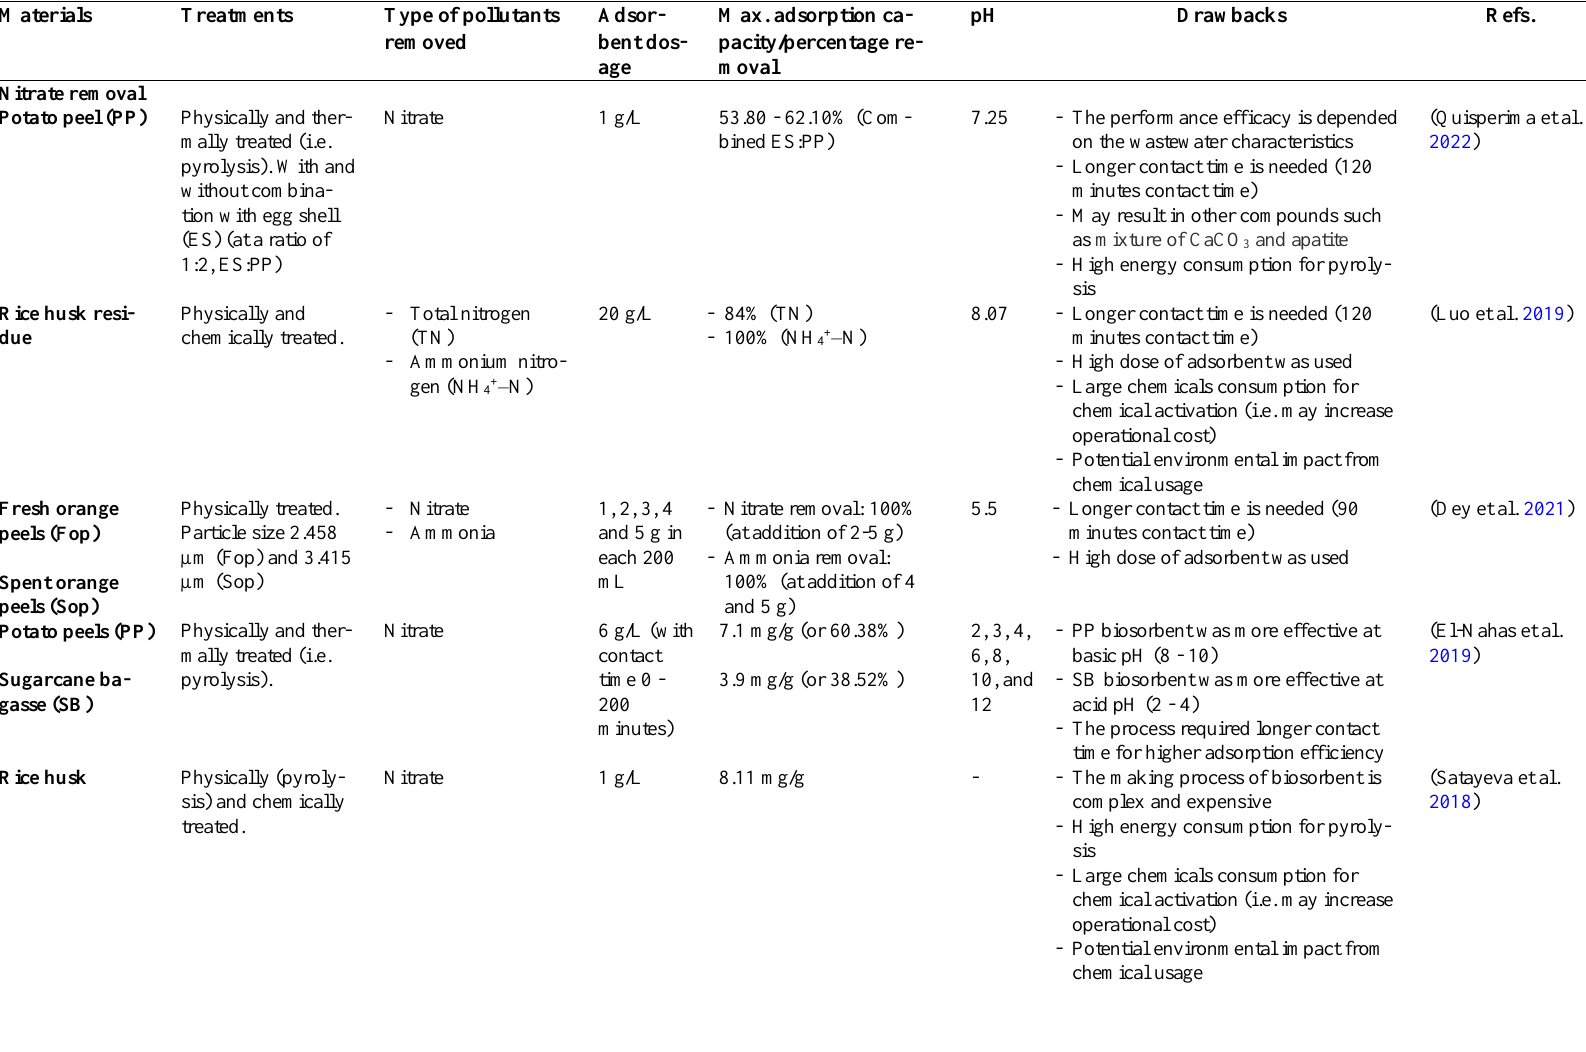
Table 5 The removal performance of nitrate, phosphorous, pesticide, pharmaceuticals, and salinity by agro-industrial waste/agricultural residues